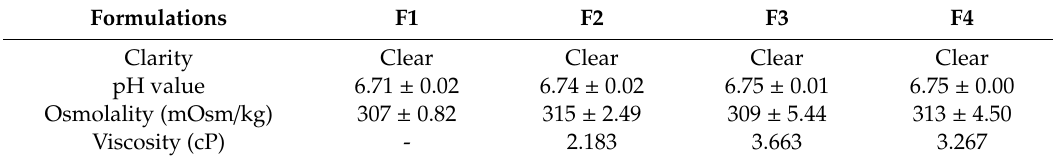
Table 3. Physicochemical properties of Achyranthis radix extract (USL) eye drop formulations.